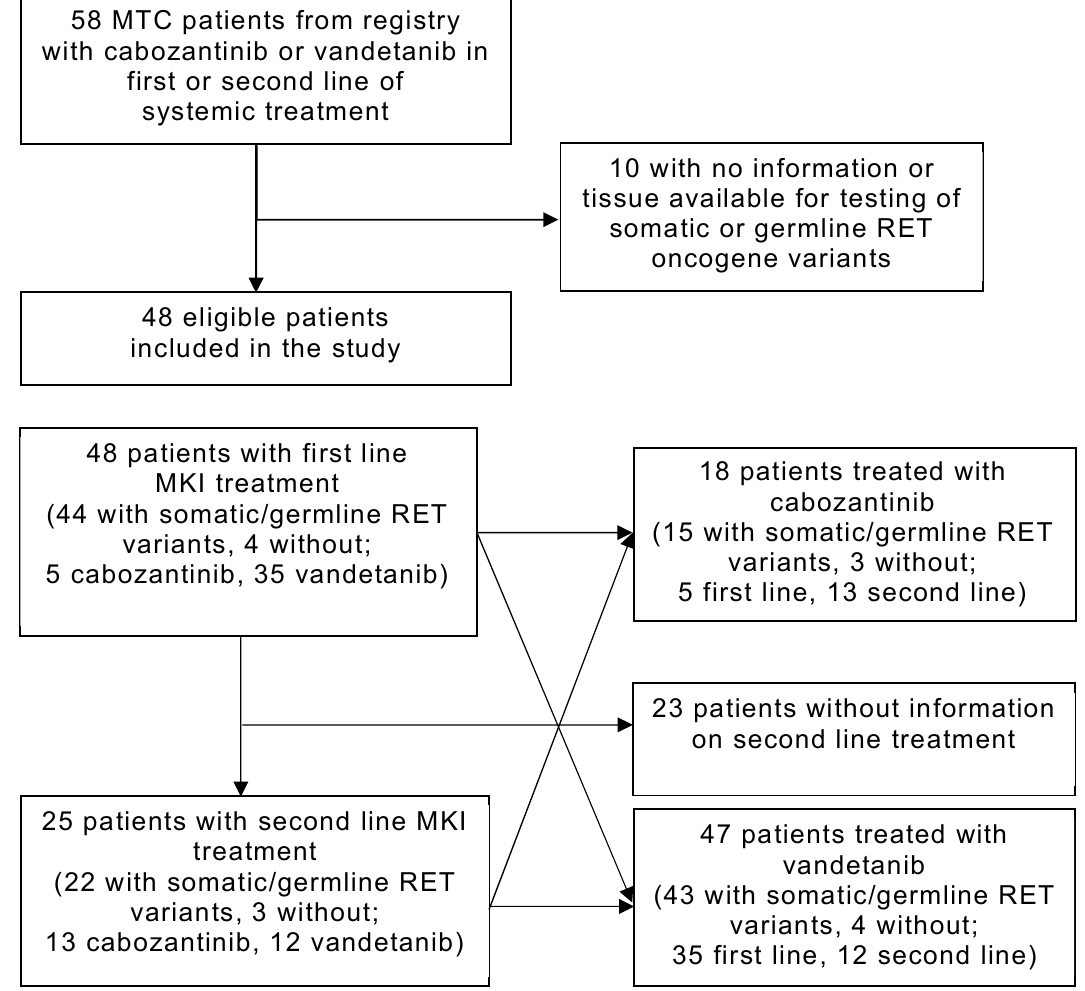
Figure 1. Selection of patients. Abbreviations: MTC, medullary thyroid cancer; RET variant, rearranged-during-transfection variant; MKI, multi-tyrosine kinase inhibitor.